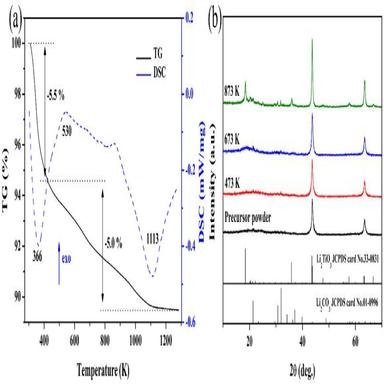
(a) TG-DSC curves of the precursor powders in air. (b) XRD patterns of the precursor powders calcined at different temperatures.